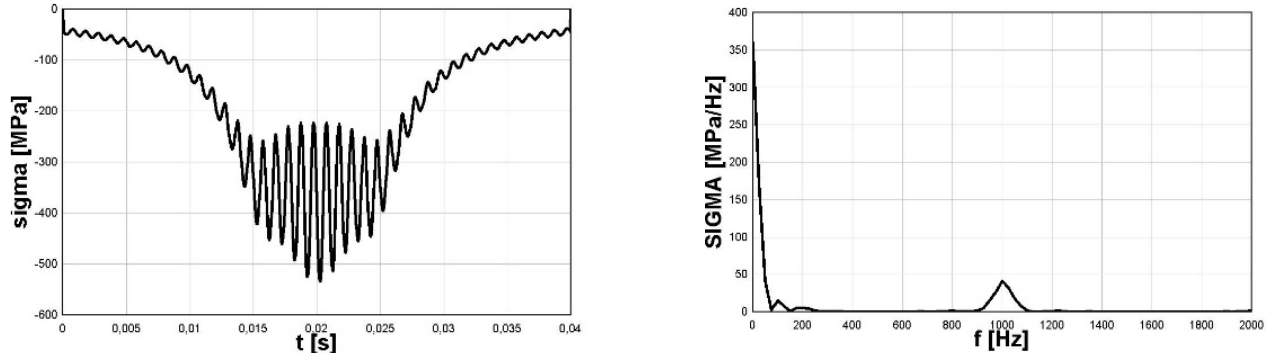
Figure 7. Time history of the analysezd function and its FFT form.